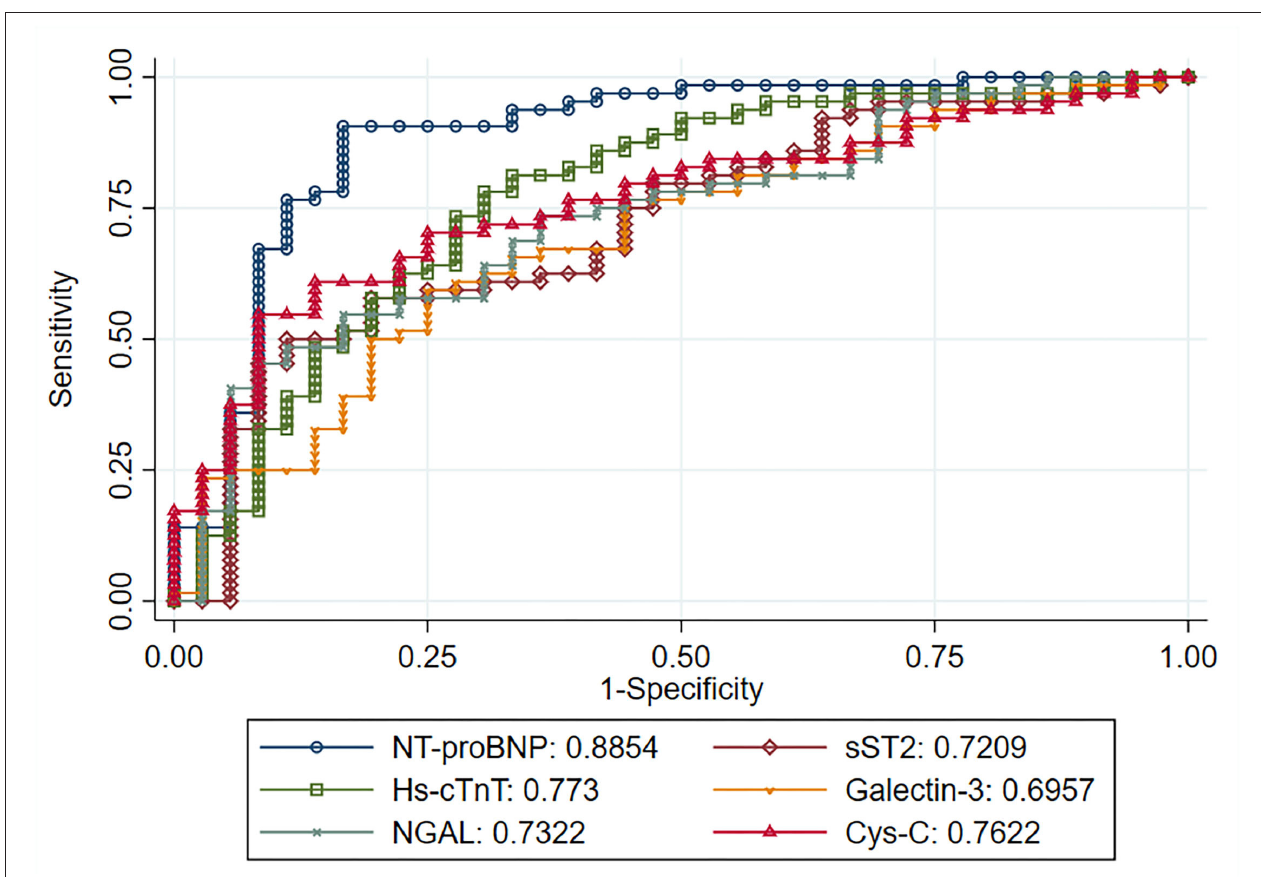
FIGURE 2 | An area under the curve of each natural log-transformed biomarker regarding the ability of discriminating patients with diastolic dysfunction. NT-proBNP, N-terminal-proB-type natiuretic peptide; Hs-cTnT, high-sensitive cardiac troponin T; Cys-C, cystatin C; NGAL, neutrophil gelatinase-associated lipocalin; sST2, soluble